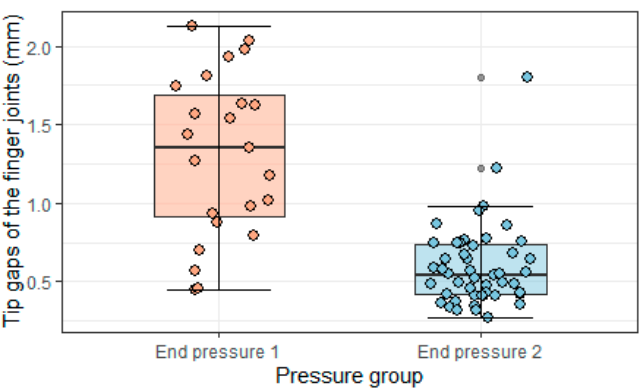
Figure 12. Tip gaps of finger joints under different pressure values.